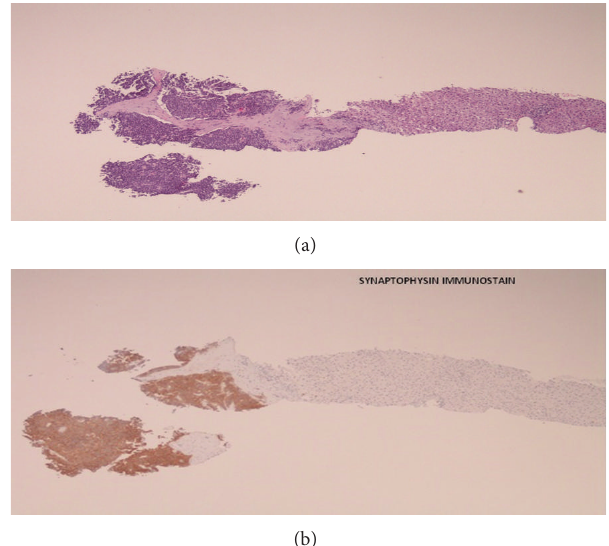
Figure 8: Liver biopsy consistent with metastatic gastric carcinoid.